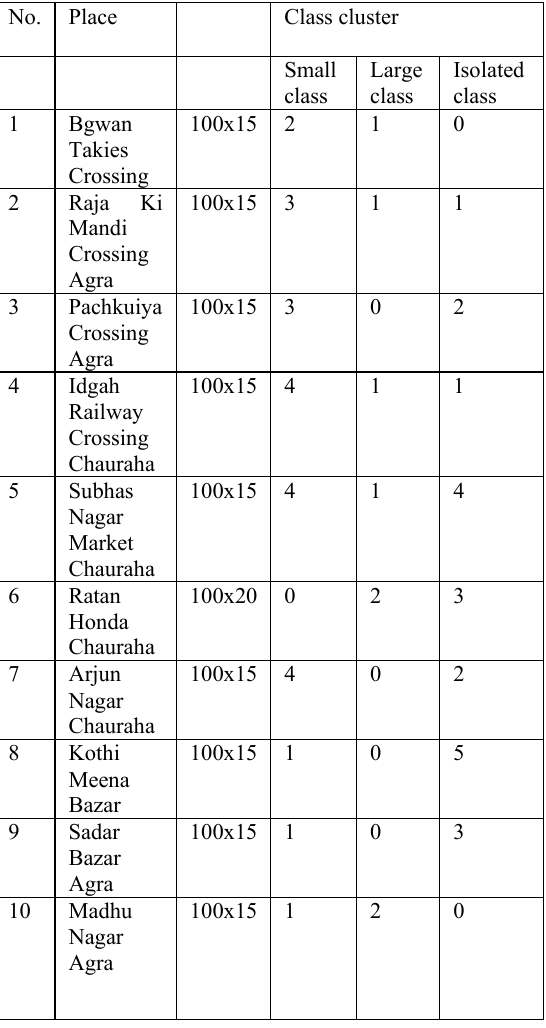
Table 1: Clustered data report for different